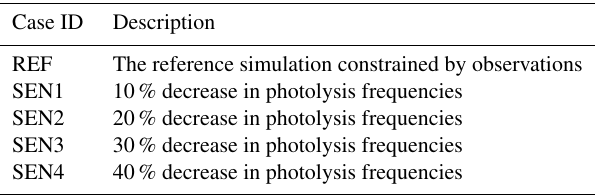
Table 3. Description of the reference simulation and sensitivity ex- periments.